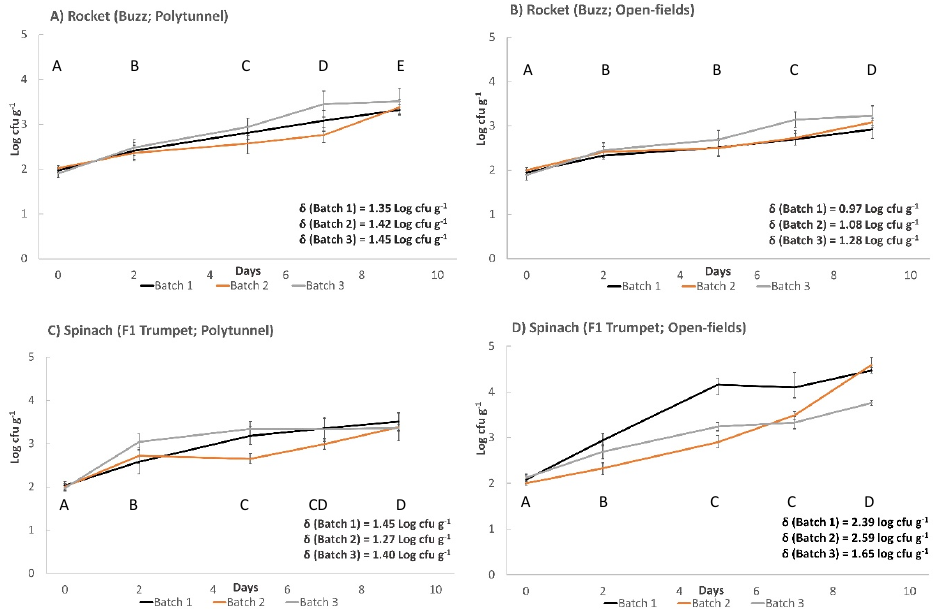
Figure 1. Growth of L. monocytogenes (100 cfu g - 1 initial inoculum) on experimental farm produce. ( A ) Polytunnel rocket (Buzz). ( B ) Open field rocket (Buzz). ( C ) Polytunnel spinach (F1 Trumpet). ( D ) Open field spinach (F1 Trumpet). Incubated at 7 °C for (6 days) followed by 12 °C (3 days). (±) error bars indicate standard deviation; δ represents growth potential value for each batch; letters A– E indicate significant differences over time.